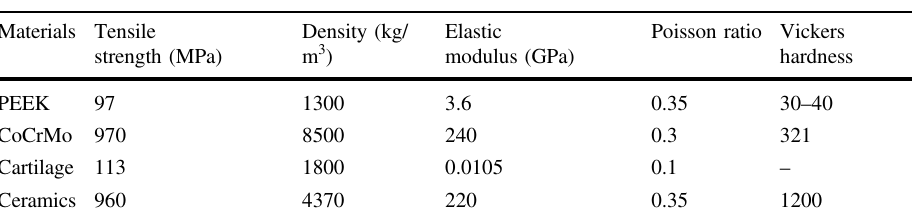
Table 1 Physical and mechanical properties [2,